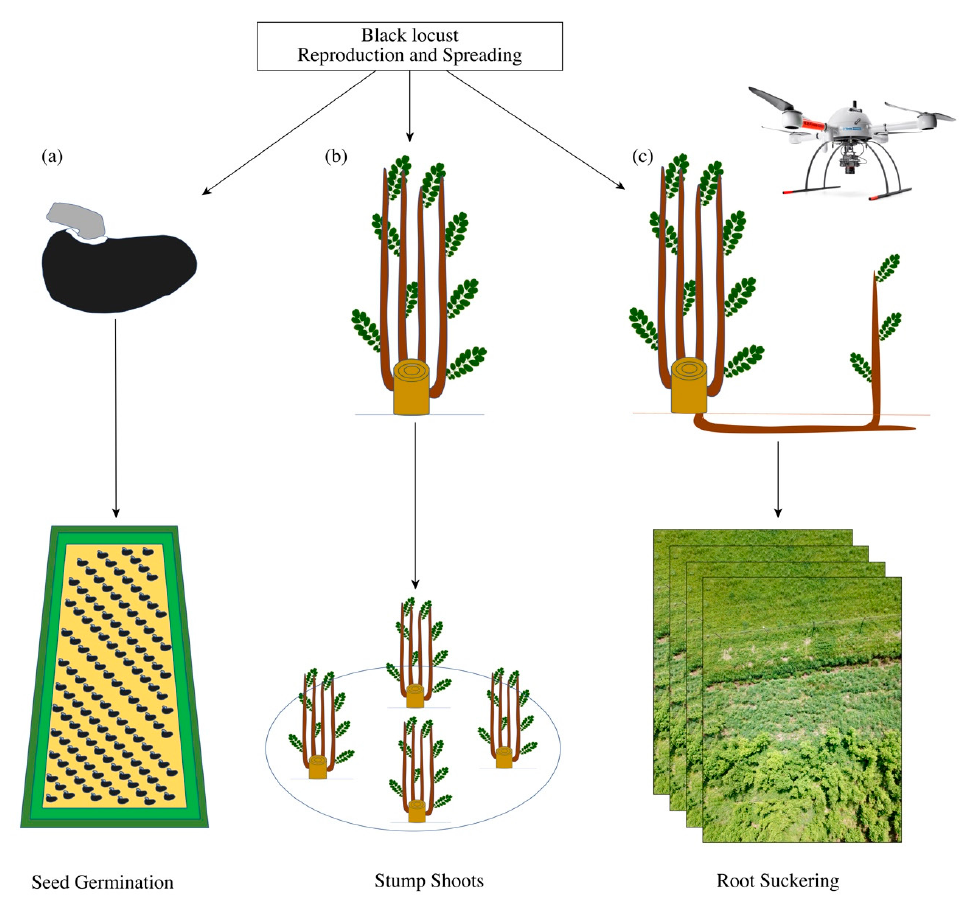
Figure 2. Flow chart showing the reproduction and spreading analysis: seed germination ( a ), stump shoot analysis ( b ), and root suckering (spreading) analysis ( c ). Seeds were seeded in planting boxes, and watered. Stump shoots were analyzed in sample plots. Spreading was estimated with the aid of UAS-images [82].